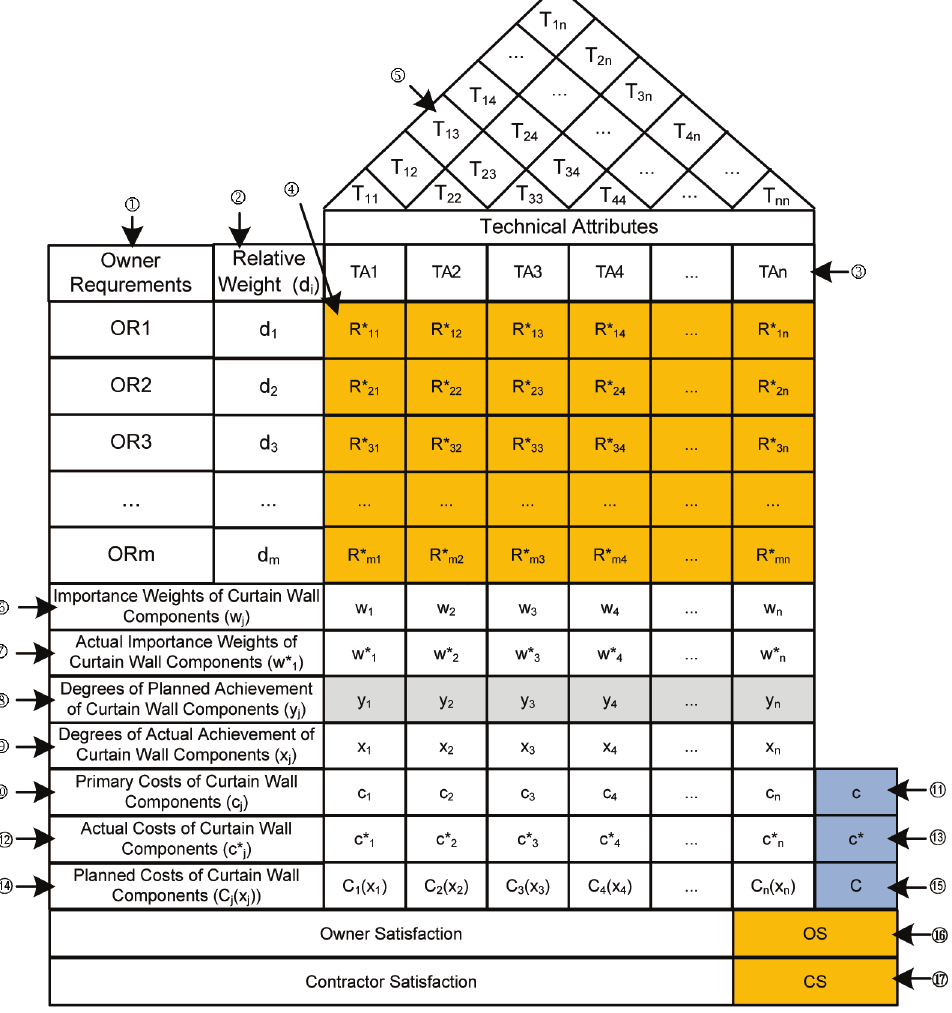
Fig. 1. The HoQ integrating cost